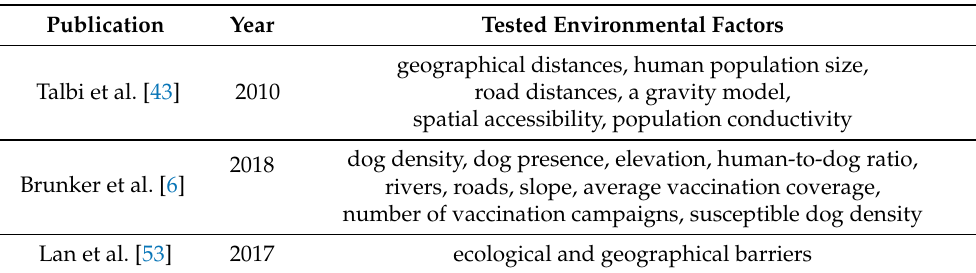
Table A1. Overview of discrete phylogeographic inference studies that assess the relevance of